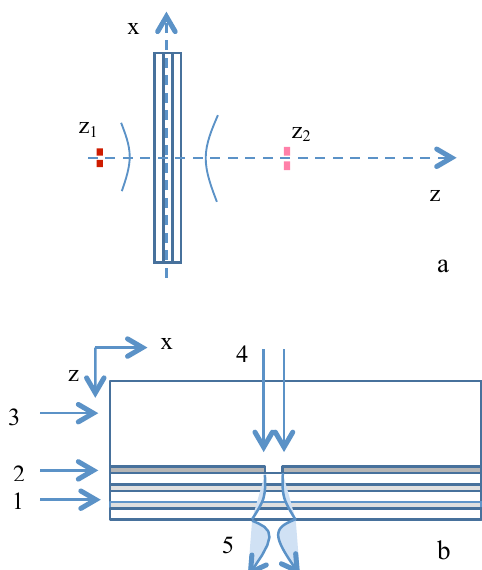
Figure 1. The principal scheme of far-field flat lens (a). The scheme of the lens calculated in the paper